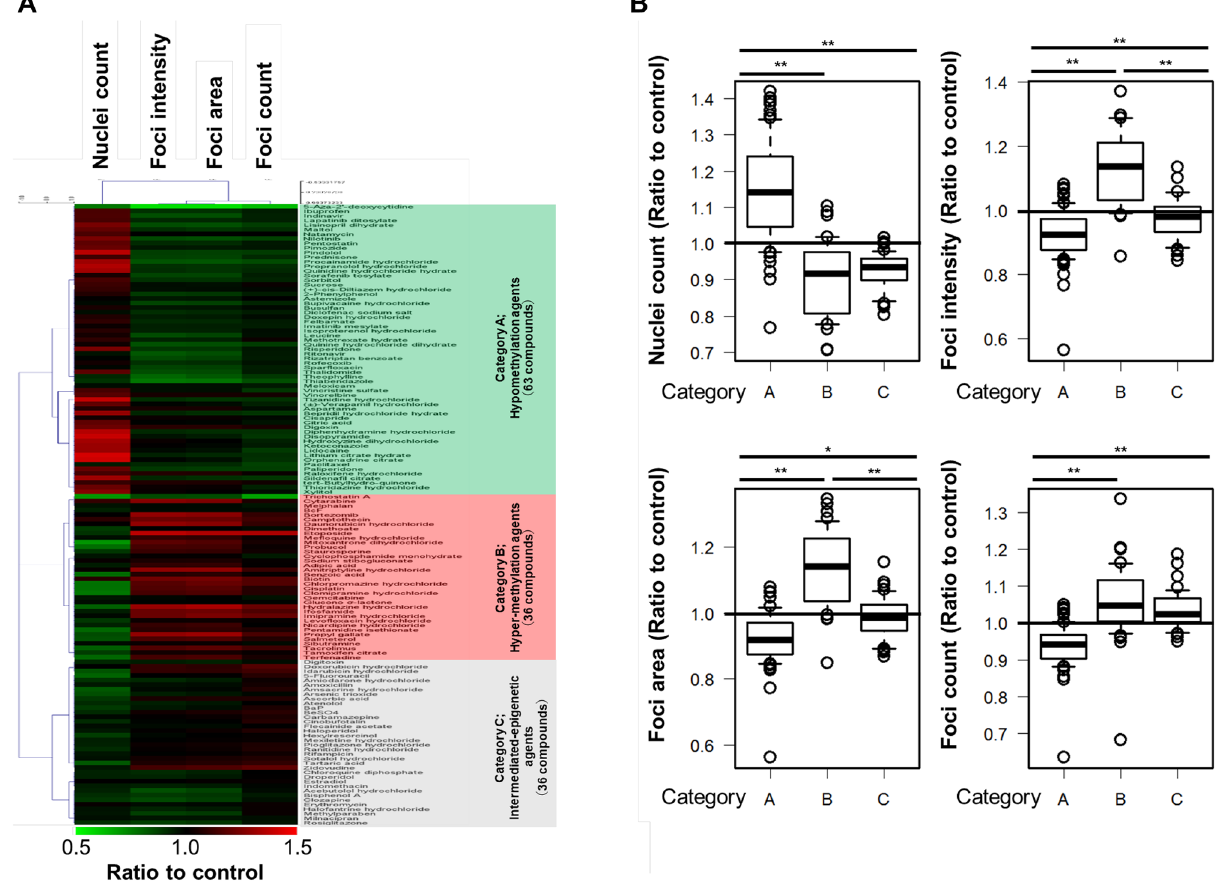
Figure 2. Screening of the modulating activities of 135 chemicals on DNA methylation using mCherry– MBD–nls human iPSCs. ( A ) Hierarchical cluster analysis of the effects of 135 chemicals on fluorescent MBD parameters. The 135 chemicals were divided into categories A (hypomethylation agents; green), B (hypermethylation agents; red), and C (intermediated epigenetic agents; gray), that decreased, increased, or had little or no effect on the fluorescent MBD parameters, respectively. ( B ) Box plots of the distributions of fluorescent MBD parameters in each category (* P < 0.05; ** P <